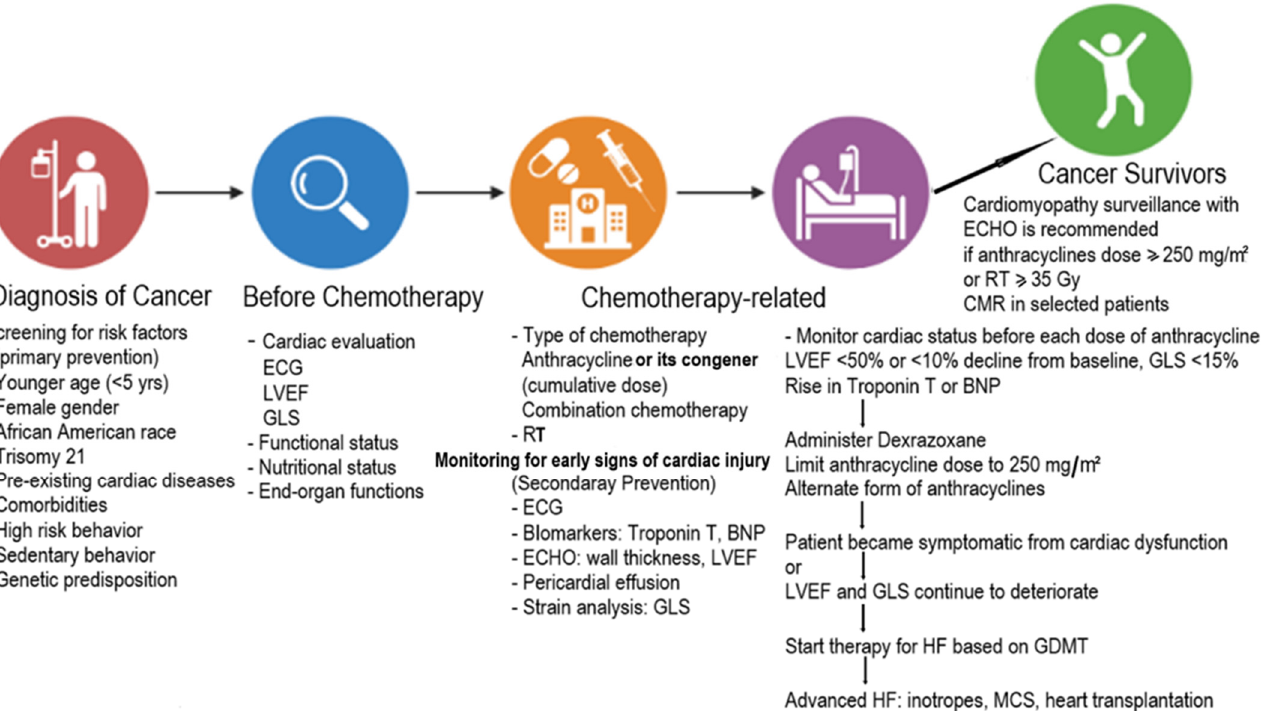
Figure 2. Continuum of cardiovascular care before, during, and after cancer therapy in children. [ECG: electrocardiogram; ECHO: echocardiogram; LVEF: left ventricular ejection fraction; GLS: global longitudinal strain; RT: radiation therapy; Gy: gray; GDMT: guideline-derived medical treatment; MCS: mechanical circulatory support; BNP: brain-type natriuretic peptide. Maximum